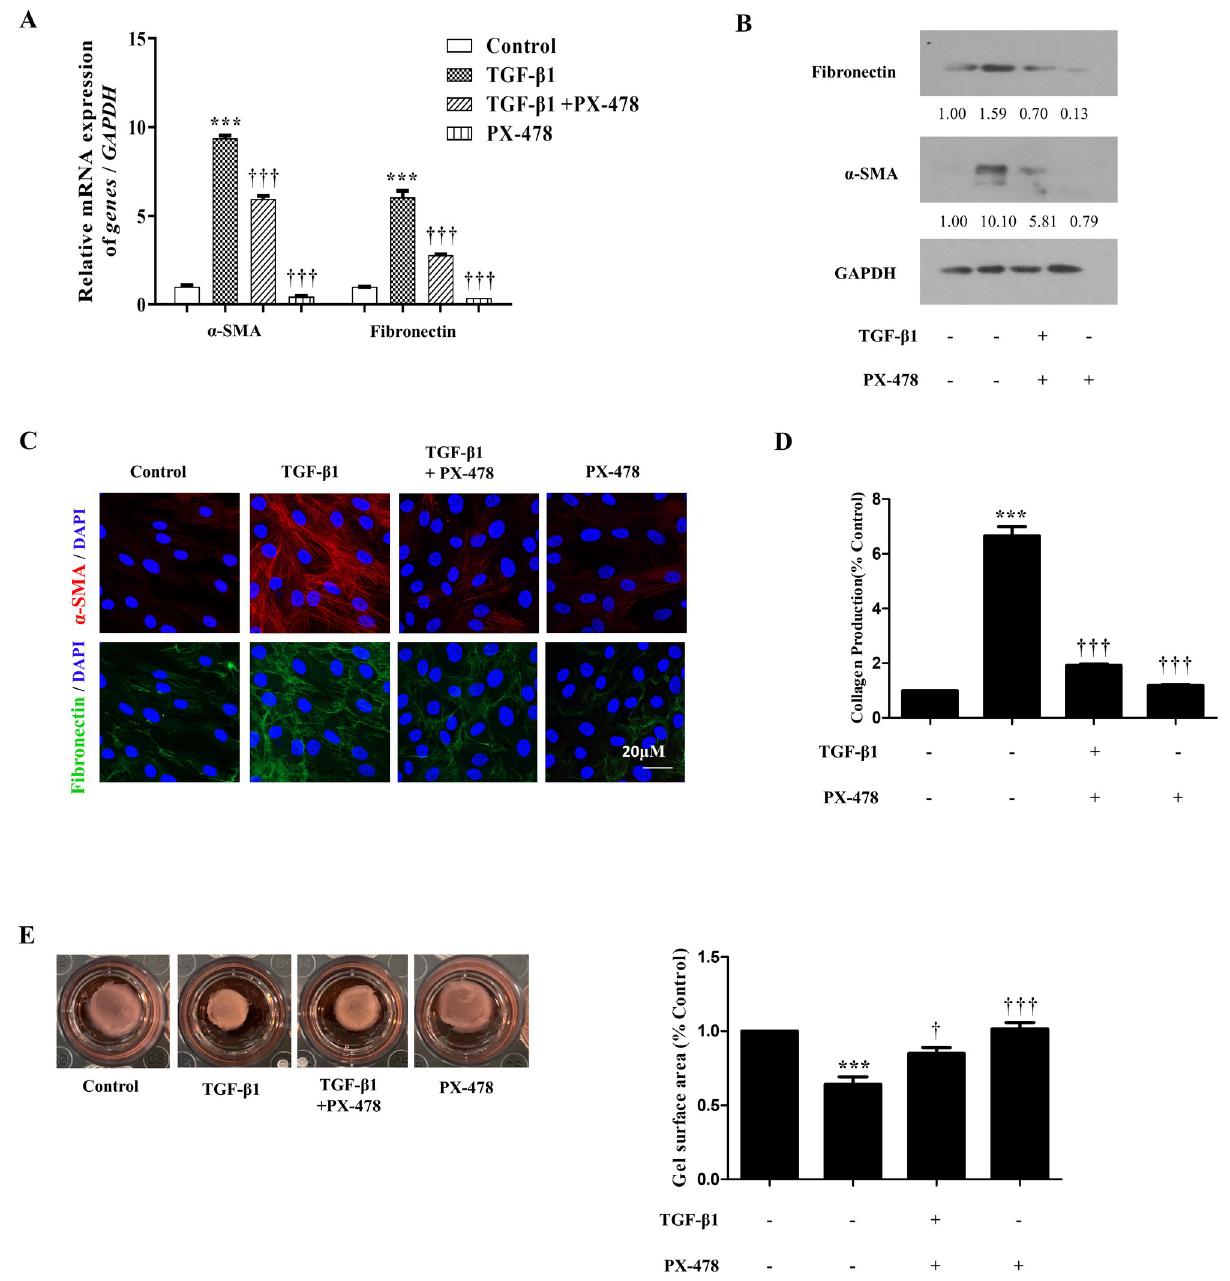
Fig 4. PX-478 inhibited expression of α -SMA, fibronectin, and collagen. (a) Gene expressions of α -SMA and fibronectin were confirmed by RT-PCR; and (b) Protein levels were detected by Western blotting. (c) Immunofluorescence was detected using a confocal laser scanning microscope. α -SMA (red), fibronectin (green), and DAPI (blue); (d) Total collagen production was measured using Sircol soluble collagen assay; (e) Contractile activity was measured using a collagen gel contraction assay, and the collagen gel areas were measured using an Image J analyzer. ��� p < 0.001 compared with control by one-way ANOVA test, †p < 0.05, †††p < 0.001 compared with TGF- β 1 by one-way ANOVA